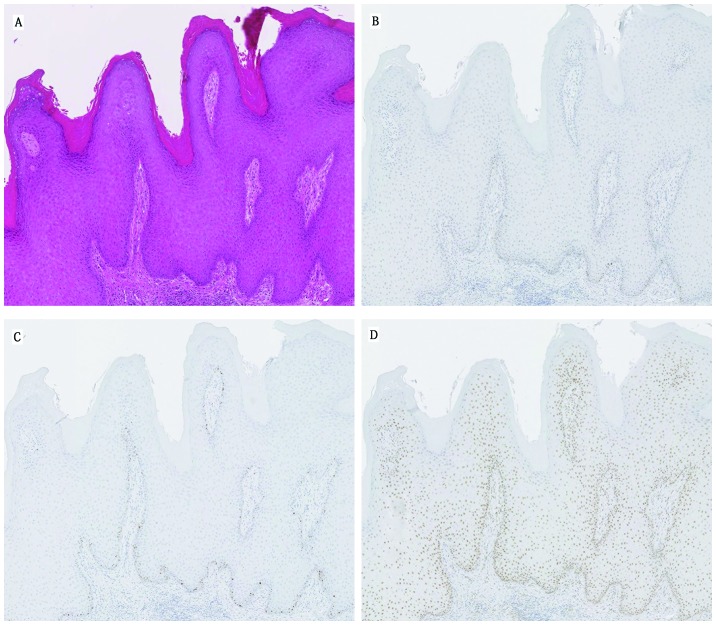
Expression of p53, Ki67 and HuR in oral verrucous hyperplasia (OVH). (A) Verrucous proliferation of squamous epithelium without dysplasia (H&E). A few positive cells are noted for (B) p53 and (C) Ki67 in basal to suprabasal layers of the epithelium. (D) HuR is detected in the nuclei of epithelial cells and cytoplasmic expression is rarely observed (A–D, magnification ×10). H&E, hematoxylin and eosin.